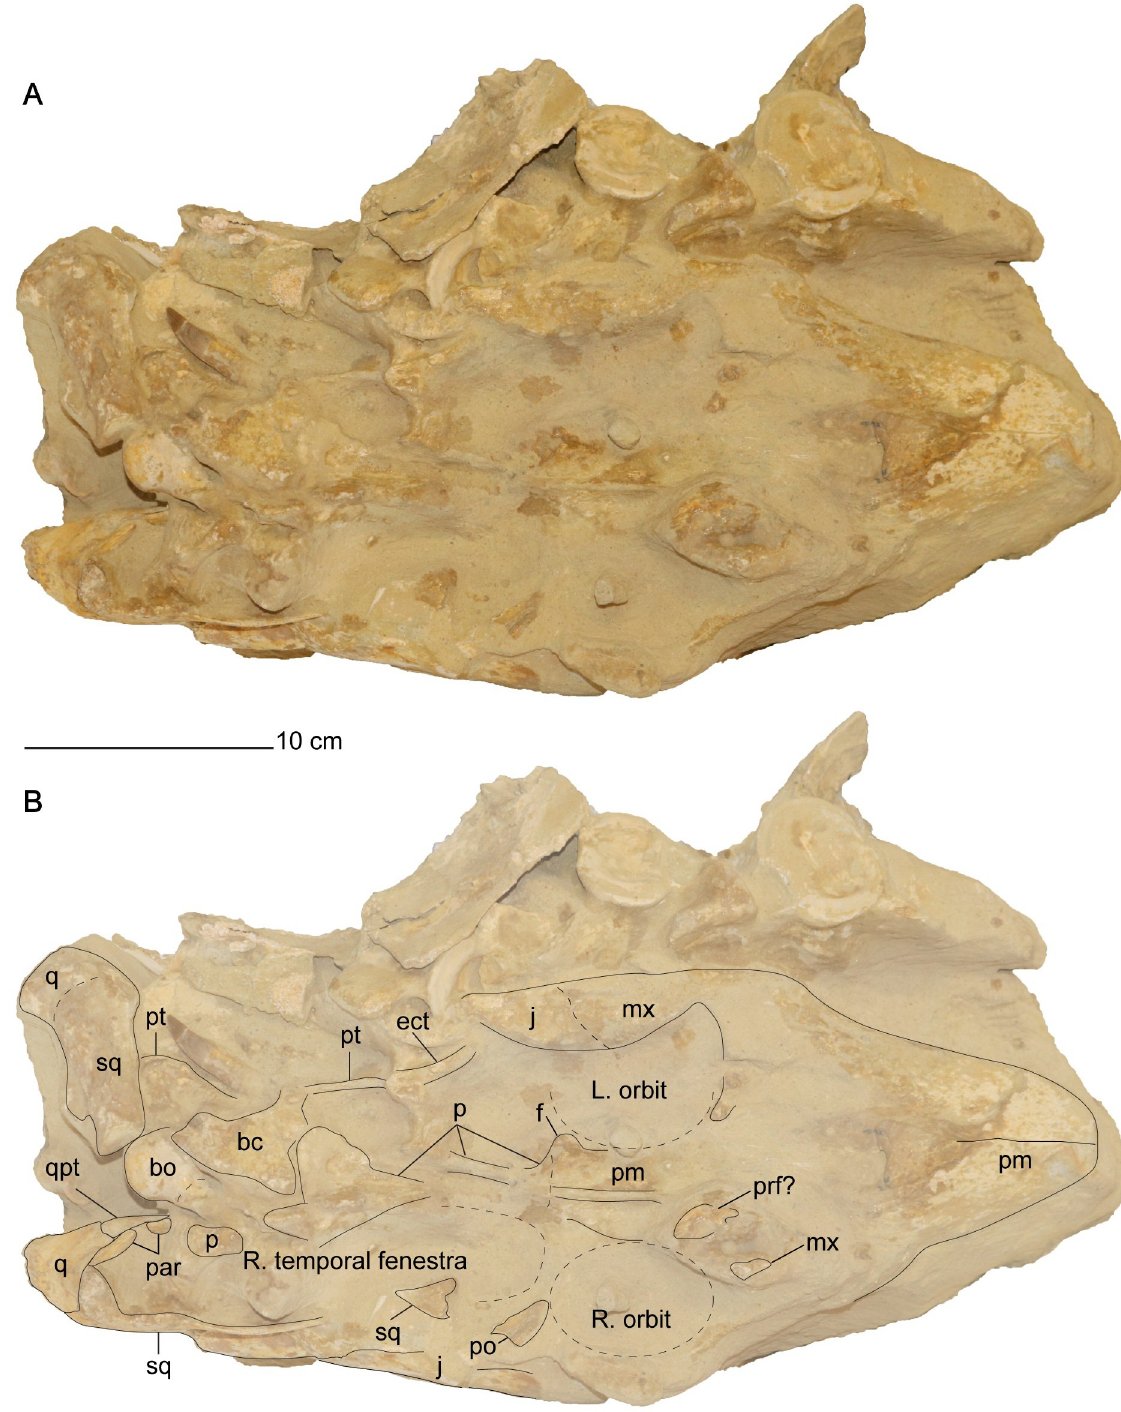
Fig 3. Cranium of Cardiocorax mukulu (MGUAN PA278) in dorsal view. A. dorsal view of cranium without labels. B. dorsal view with anatomical labels.